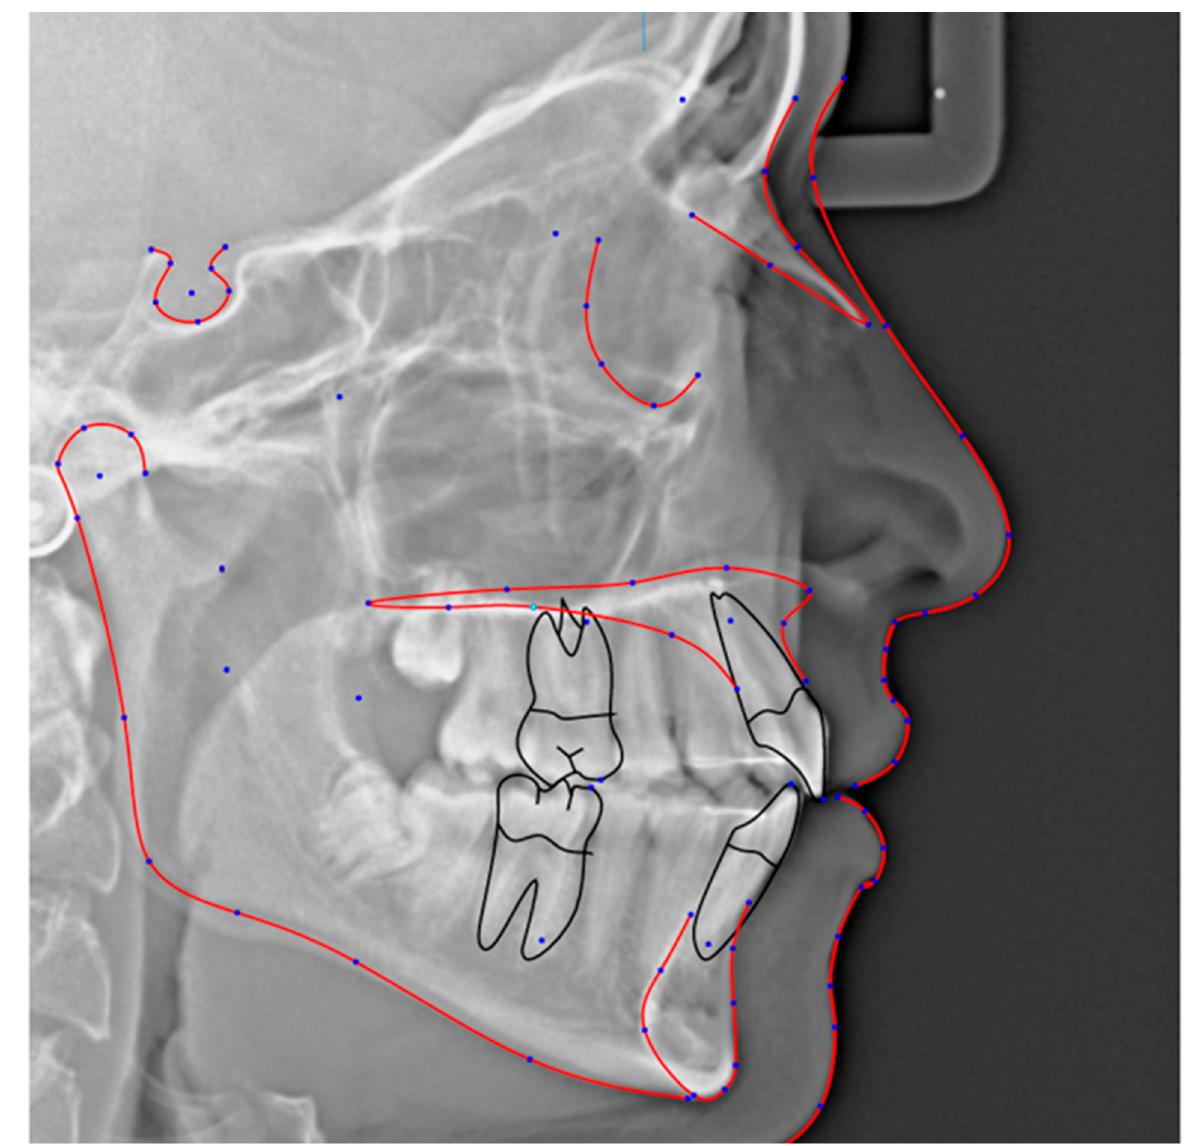
Figure 4. Example of automatic landmark location performed by the AI application of Algoceph. Note that identical outcomes of 5 separate trials provide non-scattered single point outcomes. Table 2. Differences and correlations between Algoceph (algoX and algoY) and the operators’ average (avgX and avgY). Note: significant differences are marked in bold, p < 0.01. ** significant Spearmen correlations. r > 0.729, p <